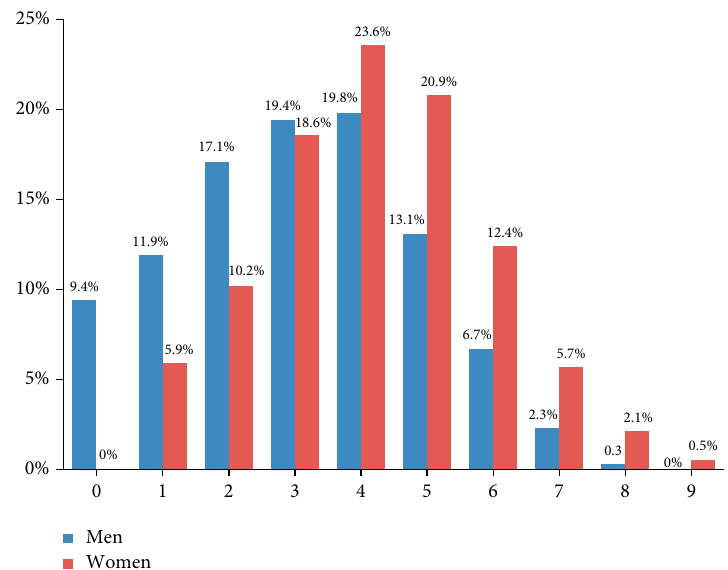
Figure 1: CHA2DS2-VASc score for men and women. Table 2: Oral anticoagulant and antiplatelet agents and other cardiovascular medications in patients with AF and two subgroups of NVAF and